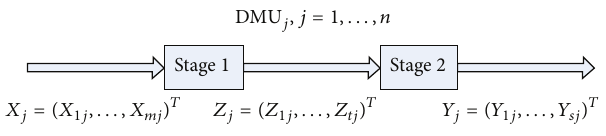
Figure 1: A system with two-stage